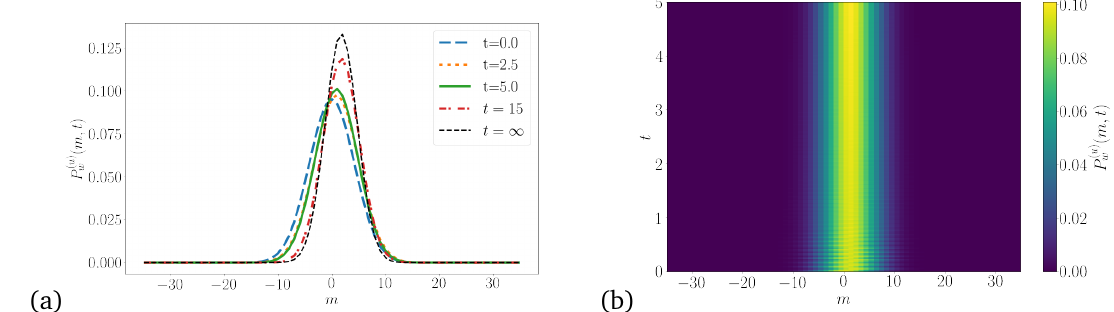
( m , t ) at times t = 0,2.5,5.0 after a w